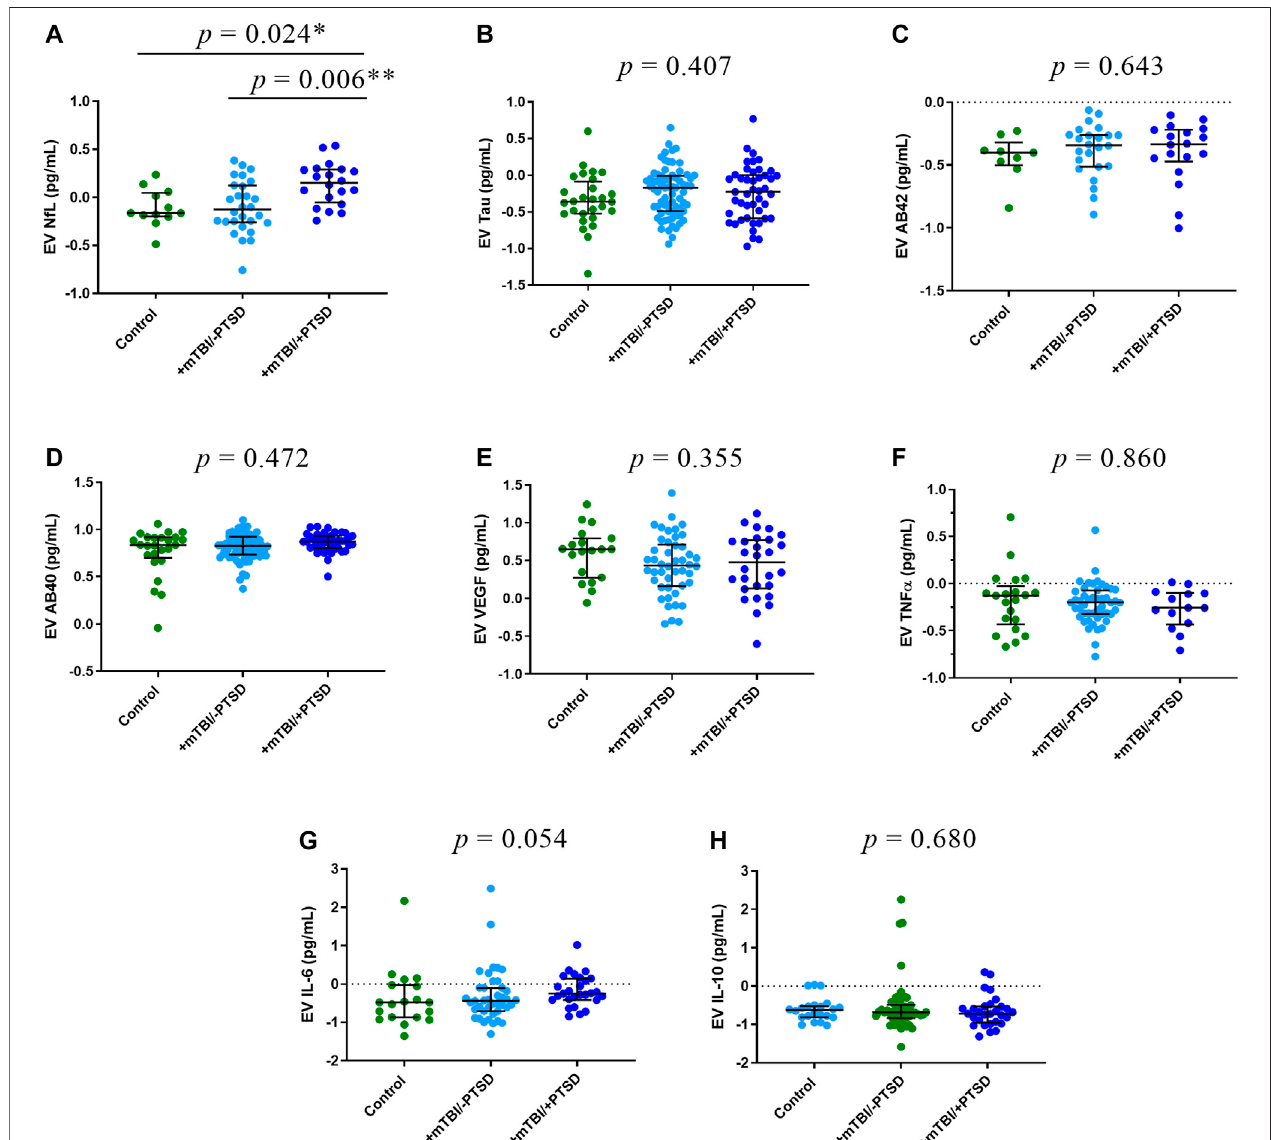
FIGURE2| EVlevelsofproteinbiomarkers.Participantswereclassi fi edintothreegroupsbasedonTBIhistoryandseverityofPTSDsymptomsasmeasuredbythe PTSD Checklist for DSM-5 (PCL-5): 1) Control (i.e., -TBI and -PTSD); 2) +mTBI/-PTSD; 3) +mTBI/+PTSD. Group comparisons were performed by using Kruskal-Wallis test followed by Dunn ’ s test, and Bonferroni method to correct for multiple comparisons. p values refer to pairwise comparisons (A) or to overall group comparisons (B – H) . Biomarker concentrations were represented as median ± IQR. Concentrations were log transformed to improve data visualization in the graphs. Abbreviations: Neuro fi lament light (NfL), Amyloid beta 42 (AB42), Amyloid beta 40 (AB40), interleukin 6 (IL-6), interleukin 10 (IL-10), tumor necrosis factor -alpha (TNF α ), and endothelial growth factor (VEGF).